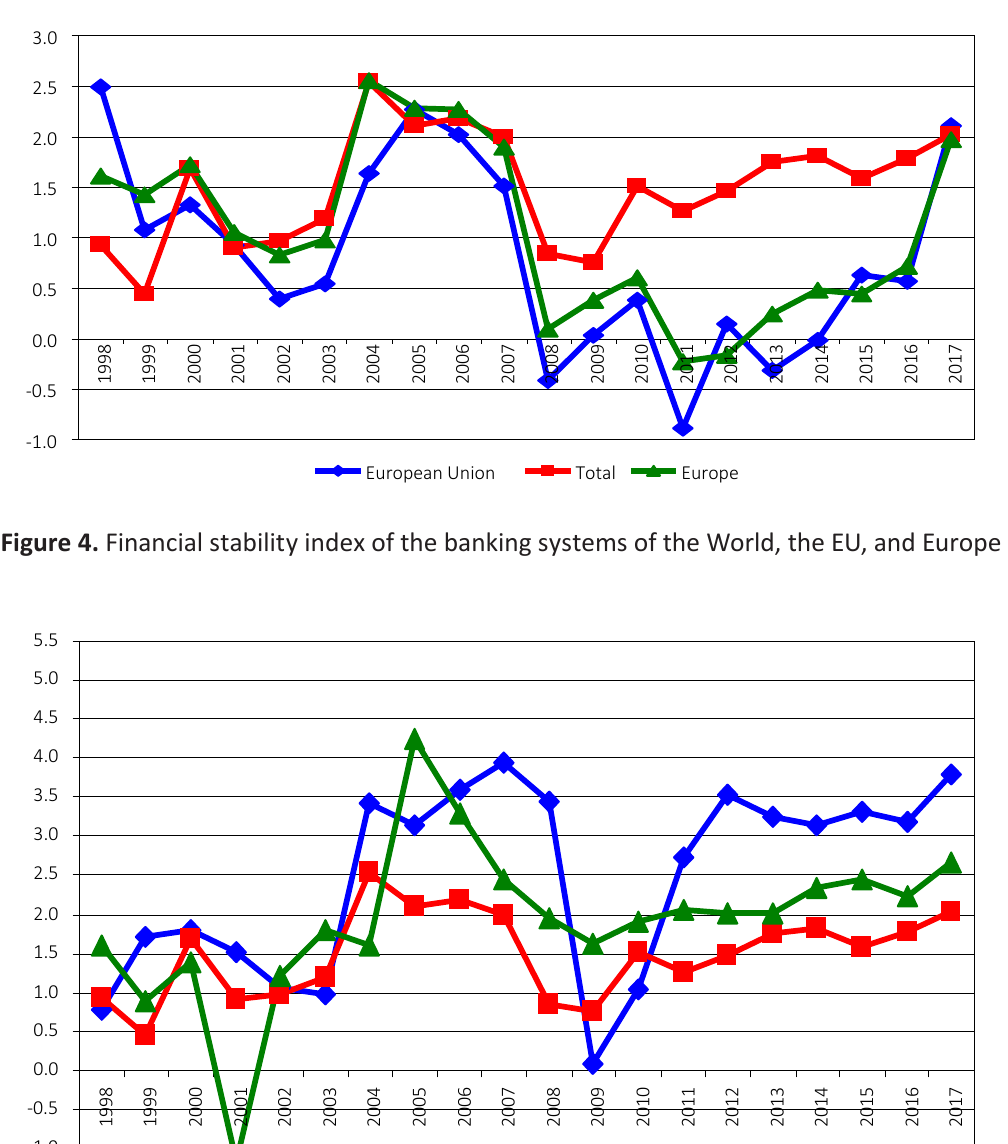
Figure 5. Financial stability index of banking systems of the World, Africa, and